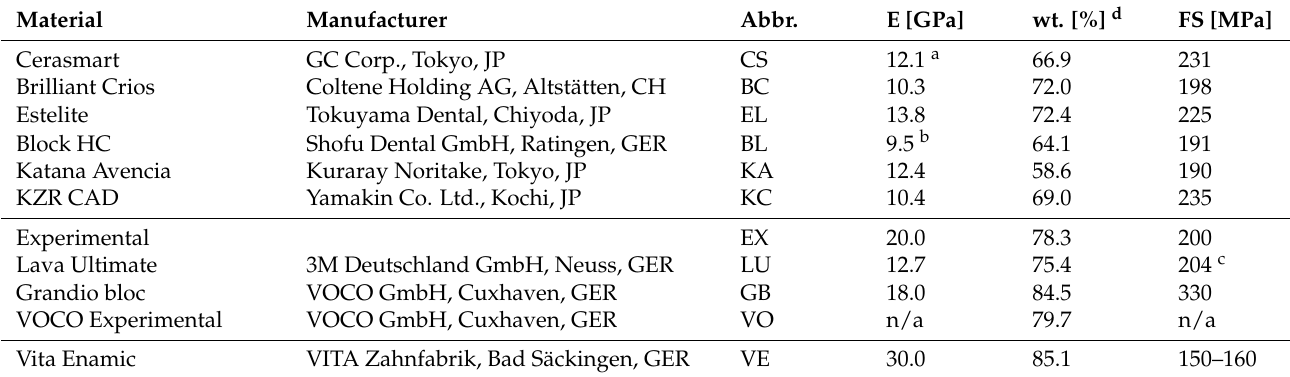
Table 1. Materials, manufacturers, abbreviations (Abbr.), modulus of elasticity (E), filler content (wt.), fracture strength (FS) according to manufacturer’s specifications or literature : (a) [20], (b) [21], (c) [22], and (d) [11]). Filler content classification: low- fill ≤ 74% wt. ≤ compact .